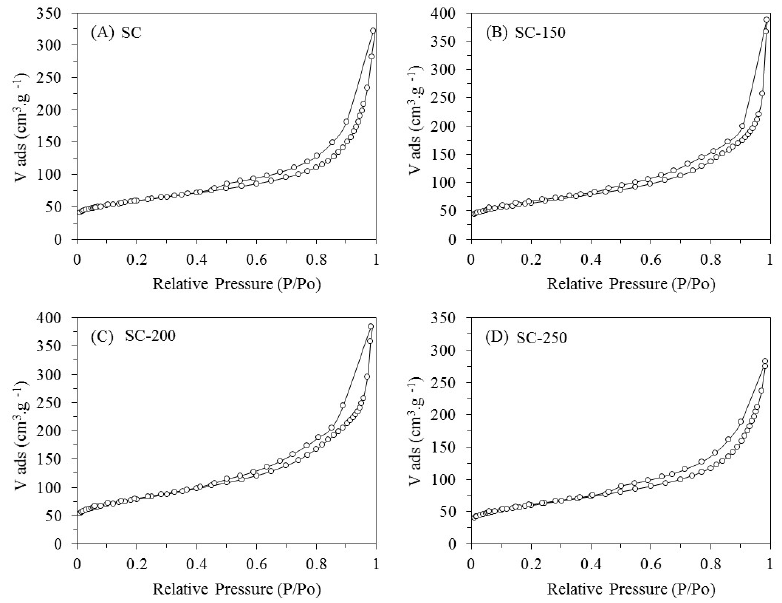
Figure 1. N 2 adsorption–desorption isotherms at − 196 °C for samples SC ( A ); SC ‐ 150 ( B ); SC ‐ 200 ( C ); SC ‐ 250 ( D ). Table 1. Brunauer–Emmett–Teller (BET) specific surface area, total pore volume, and micro ‐ and mesopores characteristics obtained by N 2 adsorption.